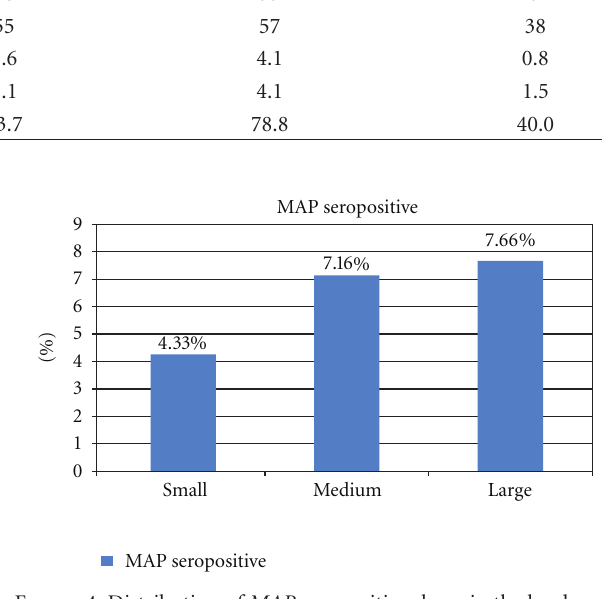
Figure 4: Distribution of MAP seropositive sheep in the herd con- sistence of the studied